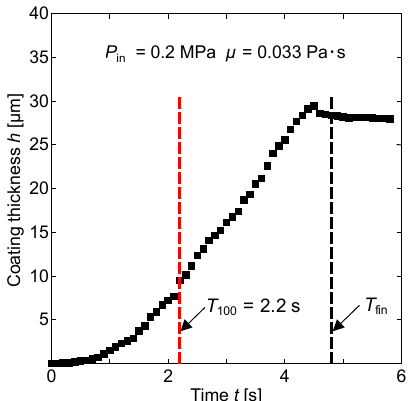
Figure 10. Fluorescence intensity distribution on a line graph.